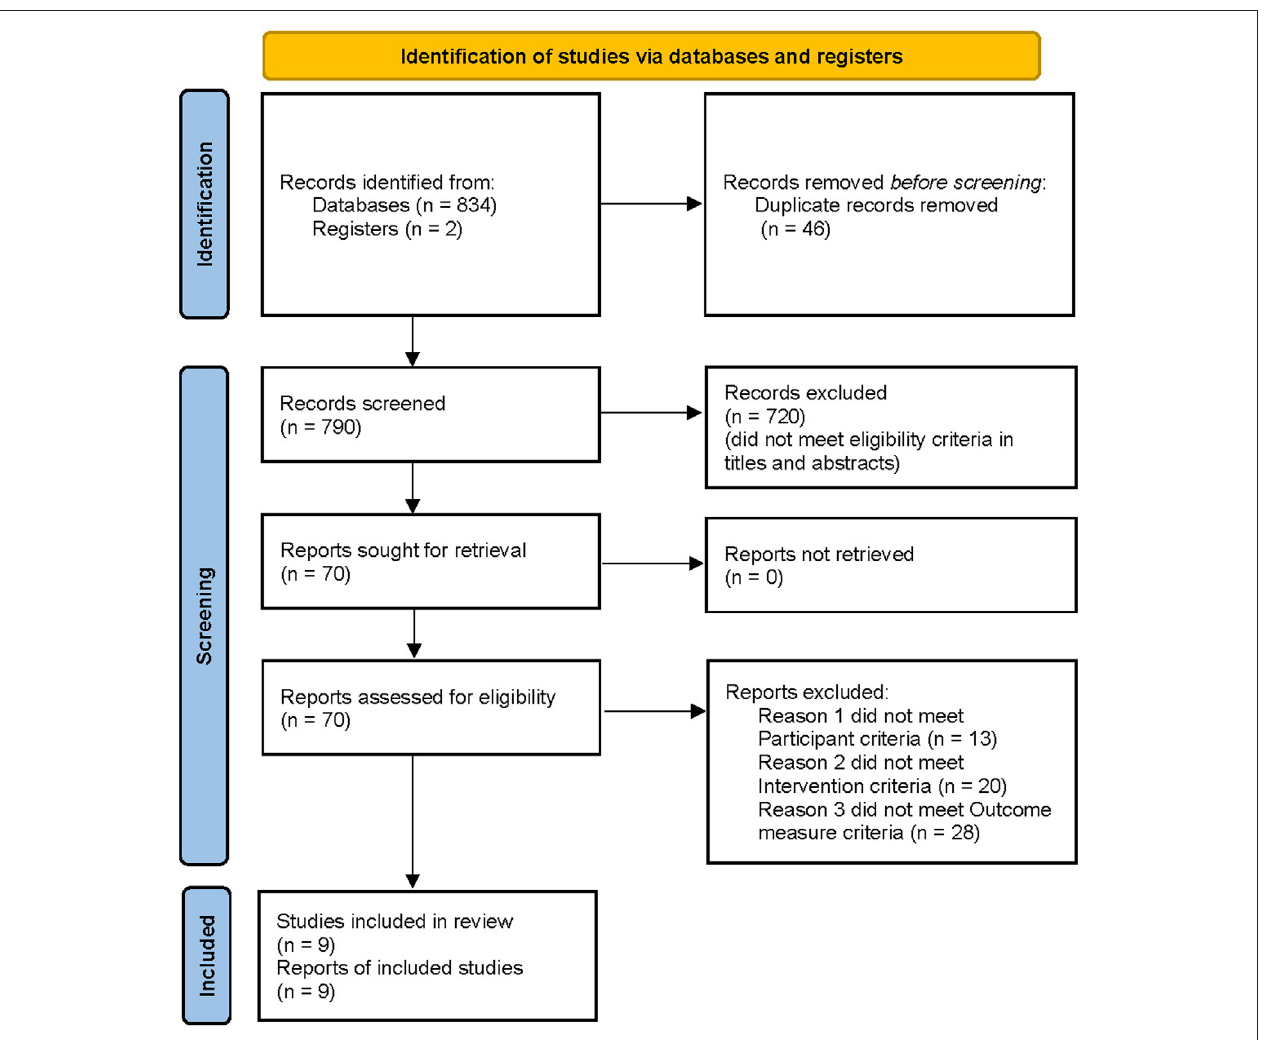
FIGURE 1 | PRISMA fl ow